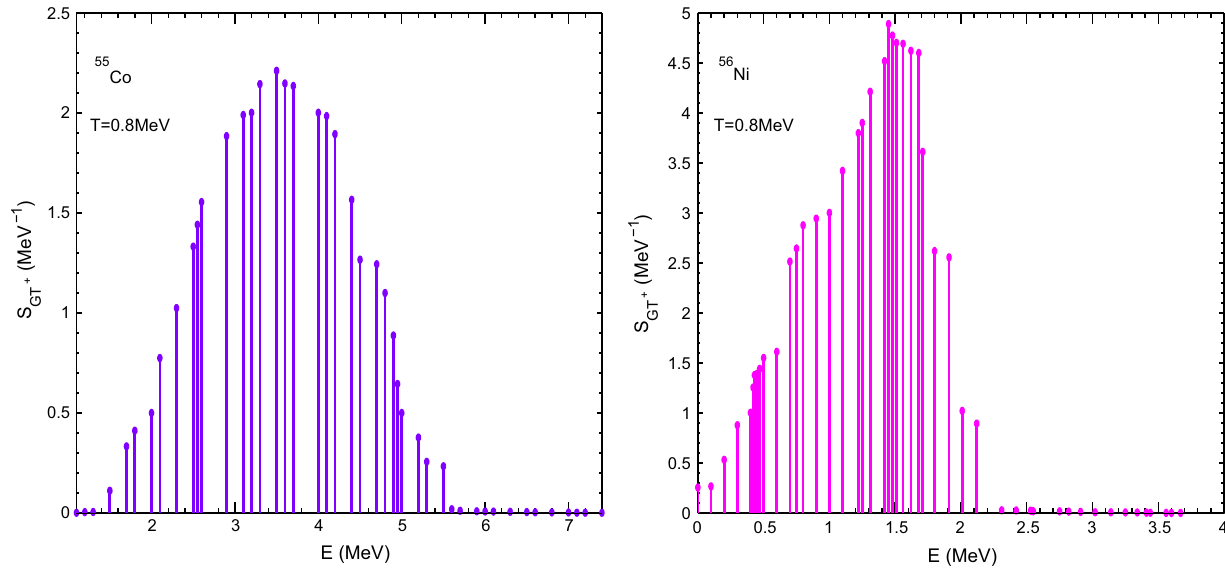
Fig. 3 The GT + distributions S GT + for nuclei 55 Co and 56 Ni as a function of the energy transfer from the electron, E = E f − E i at the temperature of T = 0 . 8